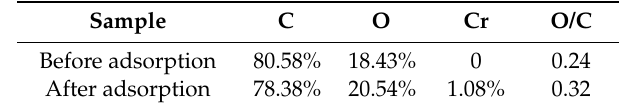
Figure 5. X-ray photoelectron spectroscopy (XPS) survey spectra of WPAC before and after Cr(VI) adsorption at pH 3. Table 2. XPS analysis of elements on the WPAC surface.